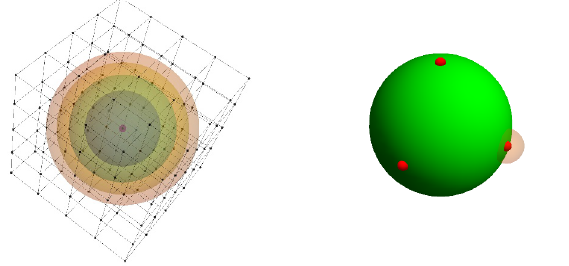
Figure 7: The left plane: Shell structure of cubic momen- tum configuration. The right plane: